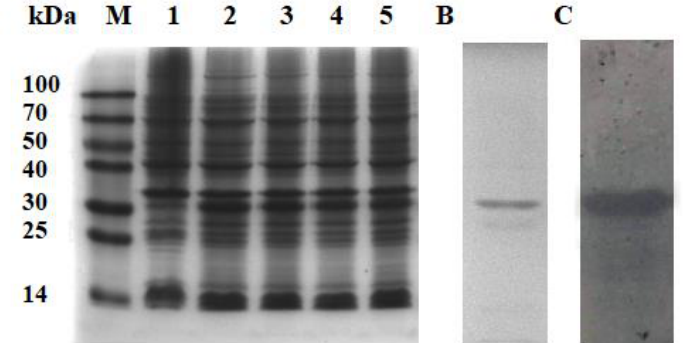
Figure 3. Recombinant protein expression and purification of ApSOCS-2. ( A ) SDS-PAGE analysis of A. pernyi SOCS-2 protein expression in E. coli induced by IPTG. M: molecular weight marker; lane 1, no IPTG treatment; lane 2, 0.3 mM IPTG treatment; lane 3, 0.5 mM IPTG treatment; line 4, 0.7 mM IPTG treatment; lane 5, 1 mM IPTG treatment. ( B ) SDS-PAGE analysis of recombinant ApSOCS-2 protein purified by affinity chromatography. ( C ) Western blot analysis of extracted ApSOCS-2 protein.